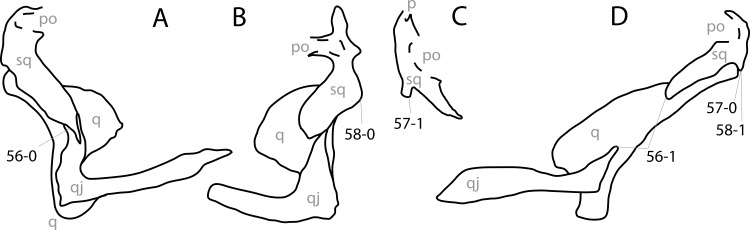
Temporal region in eusauropod skulls.Squamosal and adjacent bones in Mamenchisaurus youngi (A; traced from Ouyang & Ye, 2002), Camarasaurus lentus CM 11338 (B; traced from Madsen, McIntosh & Berman, 1995), Amargasaurus cazaui MACN-N15 (C; traced from Salgado & Bonaparte, 1991), and Diplodocinae indet. CM 3452 (D; traced from a 3D model from L Witmer), in right (A, C) and left (B, D) lateral view; illustrating the states of the characters 56, 57, and 58. Abb.: po, postorbital; q, quadrate; qj, quadratojugal; sq, squamosal. Not to scale.